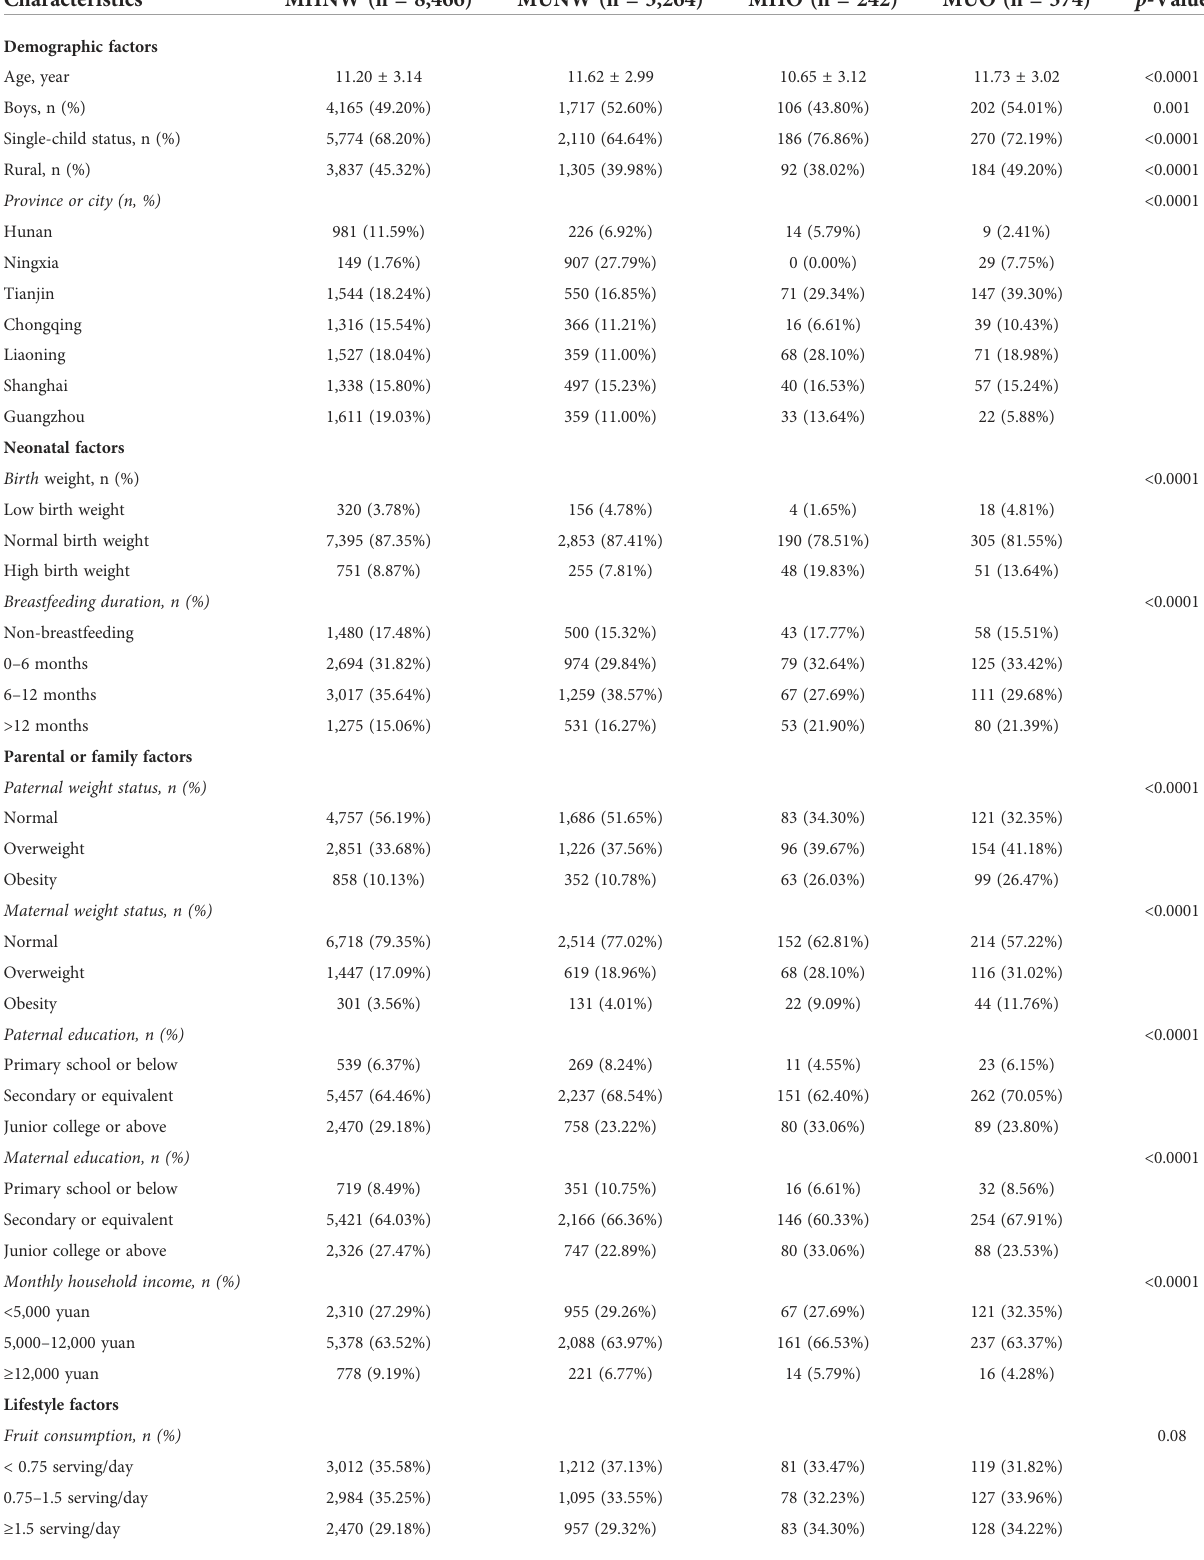
TABLE 2 Baseline characteristic of included population among different metabolic obesity phenotypes, based on 2018 consensus-based